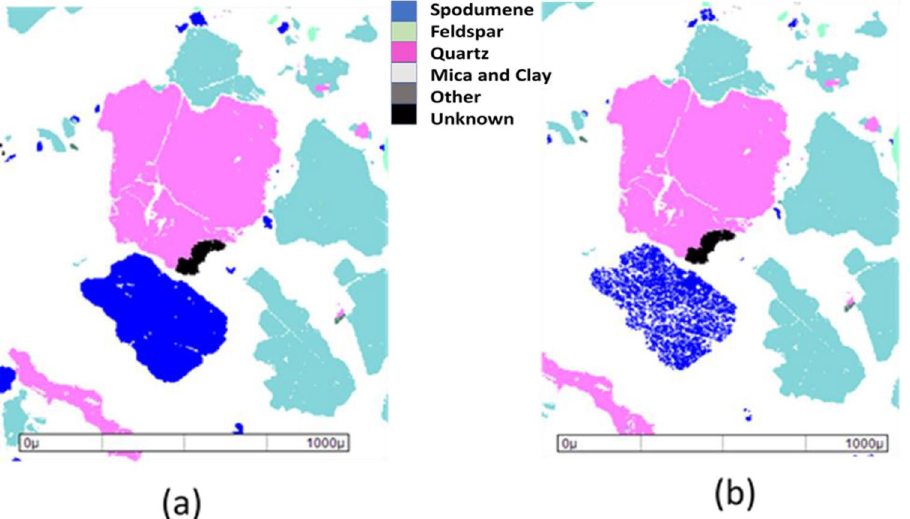
Figure 1. Estimation of particle properties ( a ) before calcination and ( b ) after